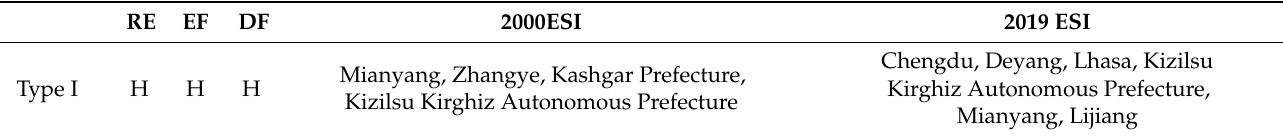
Table 6. Types of Fractal Dimension Indexes of the Economic Security in the Qinghai–Tibet